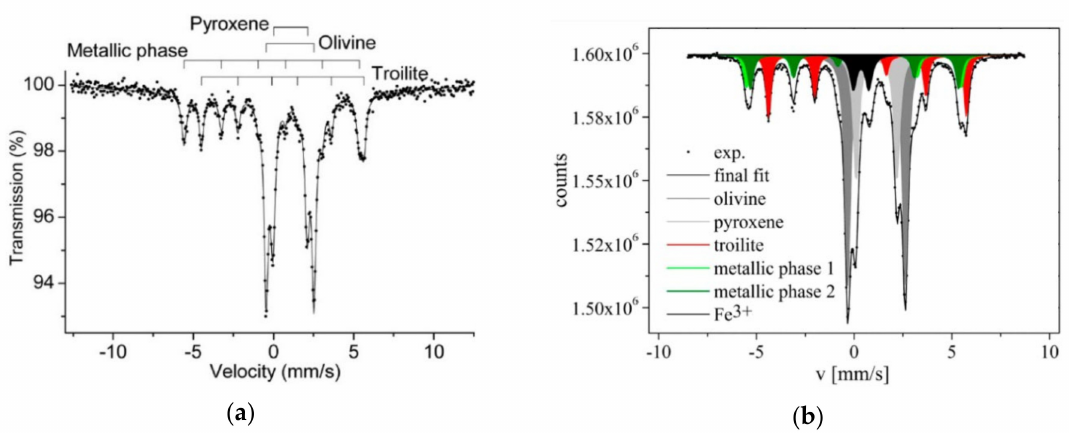
Figure 11. Room temperature Mössbauer spectra of Zag H3-6 meteorite measured in [56] ( a ) and in [57] ( b ). Indicated components are the results of the fits. Adapted from References [56,57].